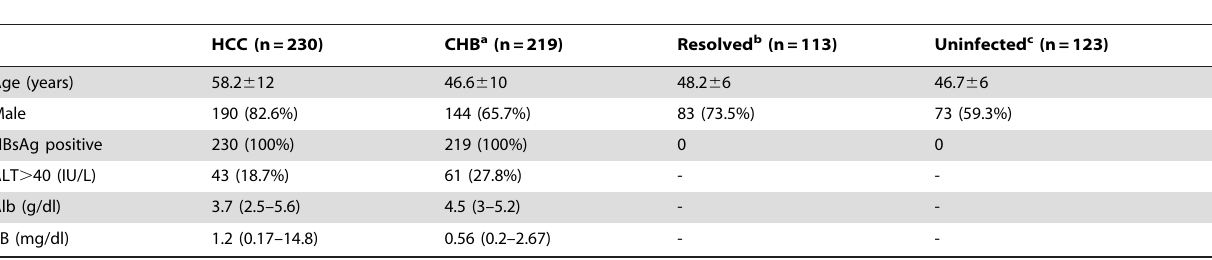
Table 1. Characteristics of participants in HCC, CHB, resolved HBV and HBV uninfected subjects in Thailand.